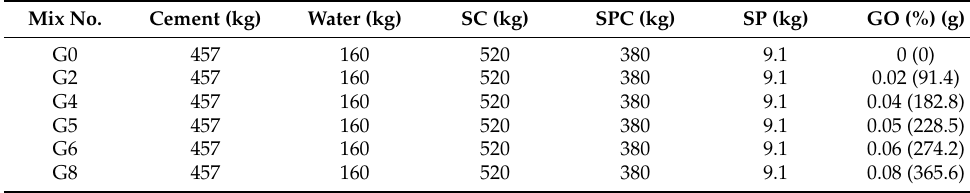
Table 3. Mix proportion (per m 3 ).